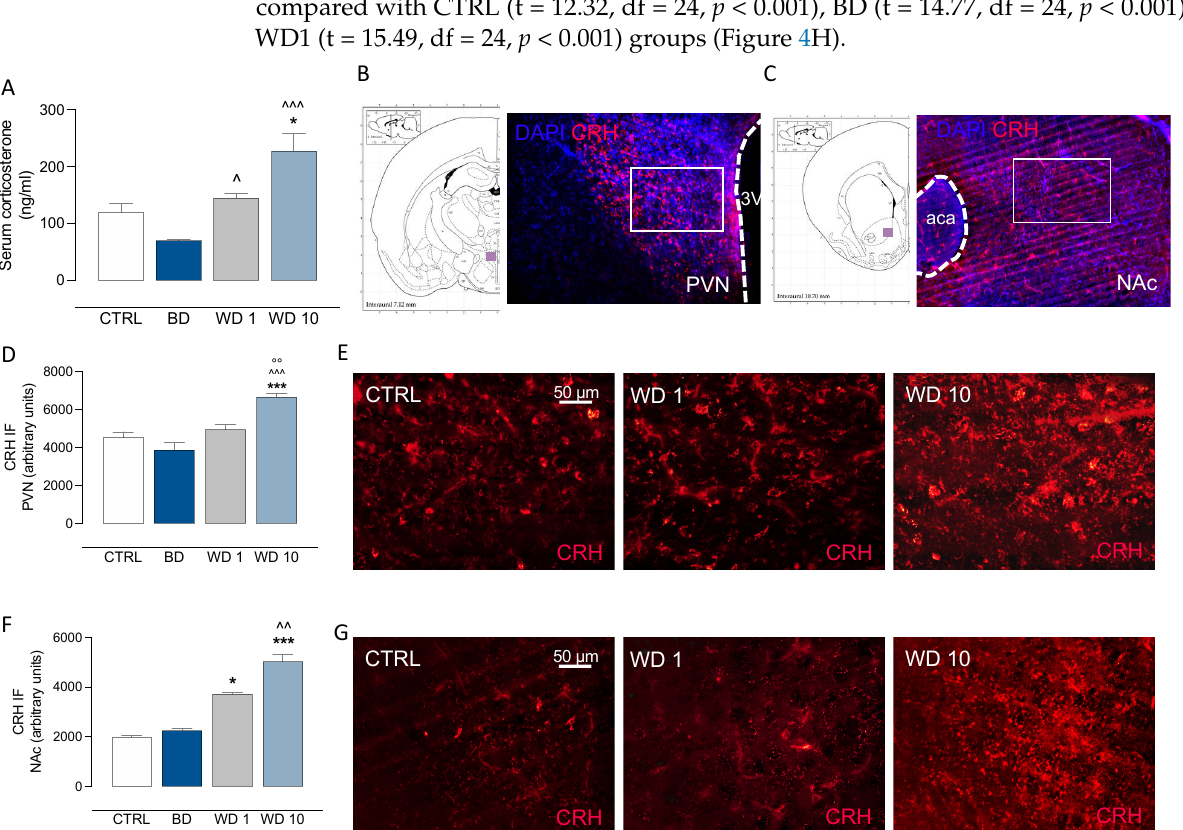
Figure 2. Binge-like alcohol exposure during adolescence perturbs the neuroendocrine stress response during withdrawal. Rats exposed a to binge-like alcohol drinking paradigm during adolescence ( A ) did not show corticosterone serum alterations on BD, whereas they displayed a progressive increase of corticosterone during WD1, when compared with BD (ˆ p < 0.05), and at WD10, with respect to CTRL (* p < 0.05) and BD (ˆˆˆ p < 0.001). When neuroendocrine stress response was assessed in terms of ( B ) hypothalamic and ( C ) extrahypothalamic CRH immunofluorescence, we found ( D , E ) a significant increase in CRH immunofluorescence in the PVN at WD10, when compared with CTRL (*** p < 0.001), BD (ˆˆˆ p < 0.001) and WD1 ( ◦◦ p < 0.01) and ( F , G ) a significant increase in CRH immunofluorescence in the NAc at WD1, with respect to CTRL rats (* p < 0.05), and at WD10 with respect to CTRL (*** p < 0.001) and BD (ˆˆ p < 0.01) rats. PVN: paraventricular hypothalamic nucleus; 3V: third ventricle; NAc: nucleus accumbens; aca anterior commissure. BD: binge day; WD1: withdrawal day 1; WD10: withdrawal day 10; CTRL: water-exposed control group. Each bar represents the mean of n = 7 rats; error bars indicate